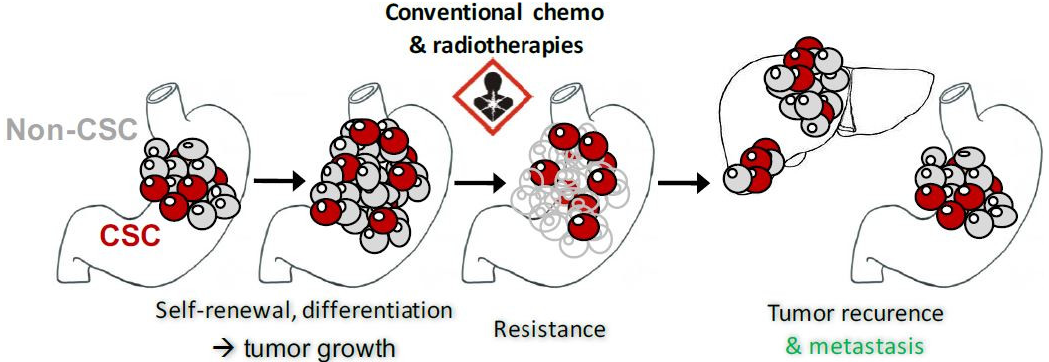
Figure 2. schematic representation of gastric cancer stem cells (GCSC) properties. Figure 2. Schematic representation of gastric cancer stem cells (GCSC)